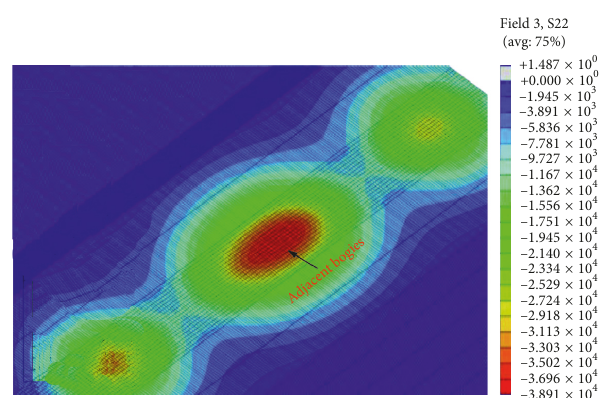
Figure 11: Dynamic stress contour at the bottom of the subgrade bed bottom